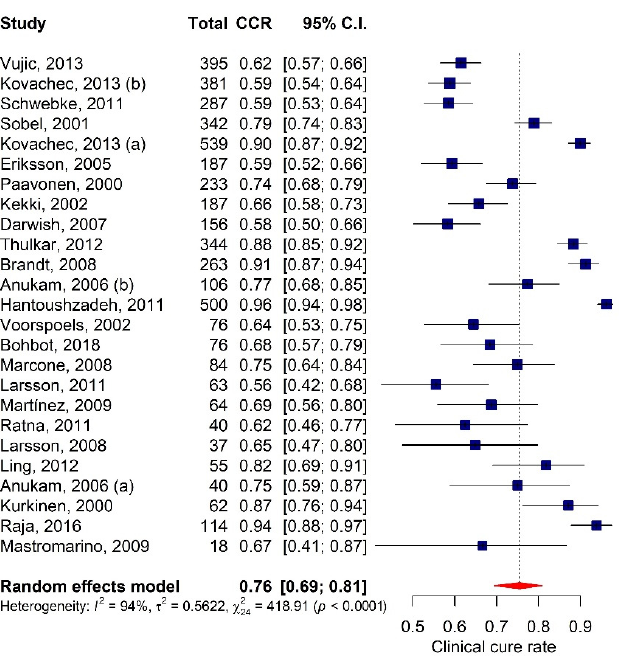
Figure 2. Forest plot of the meta-analysis of CCR of treatments for bacterial vaginosis. A funnel plot was then realized to evaluate the existence of publication bias in the final data set (see Figure 3). Egger’s linear regression test was also used to reveal any pub- lication bias and possible asymmetric data distribution in the selected studies. No publi- cation bias was observed according to Funnel plot symmetry and Egger’s linear regression test ( p = 0.1097).